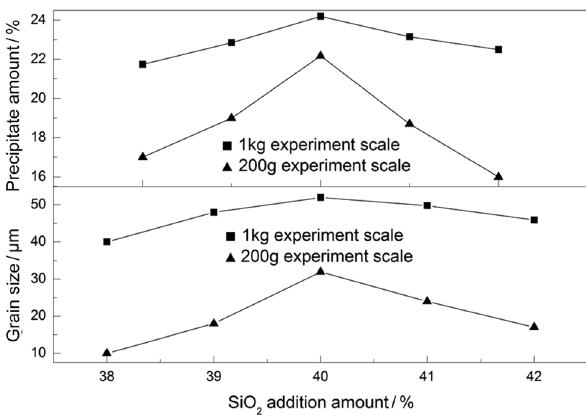
Figure 11: Precipitate quantity and average grain size of rutile with different addition amounts of SiO 2 .